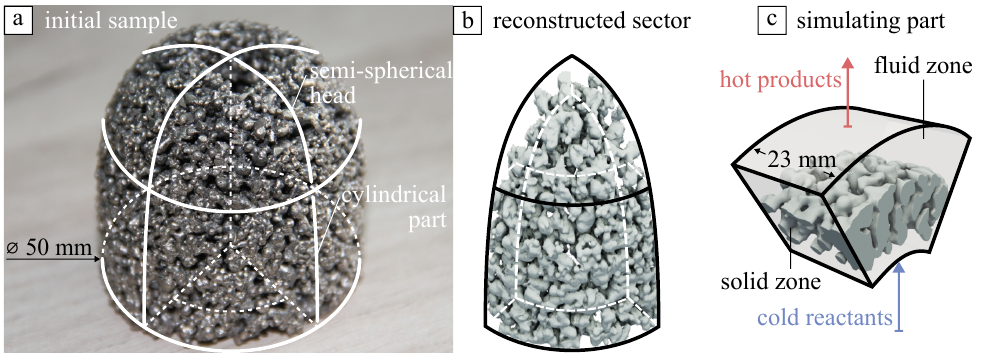
Figure 3. ( a ) Photography of porous Ni-Al sample and ( b ) fragment reconstructed using X-ray CT ( c ) computational domain consisting of fluid and solid